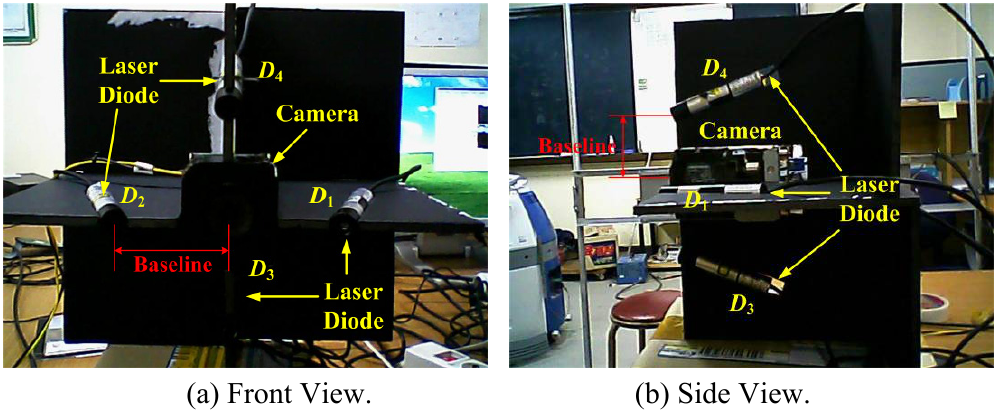
Figure 12. Prototype of the proposed 3D lug pose detection sensor with a monocular camera and four laser line diodes.